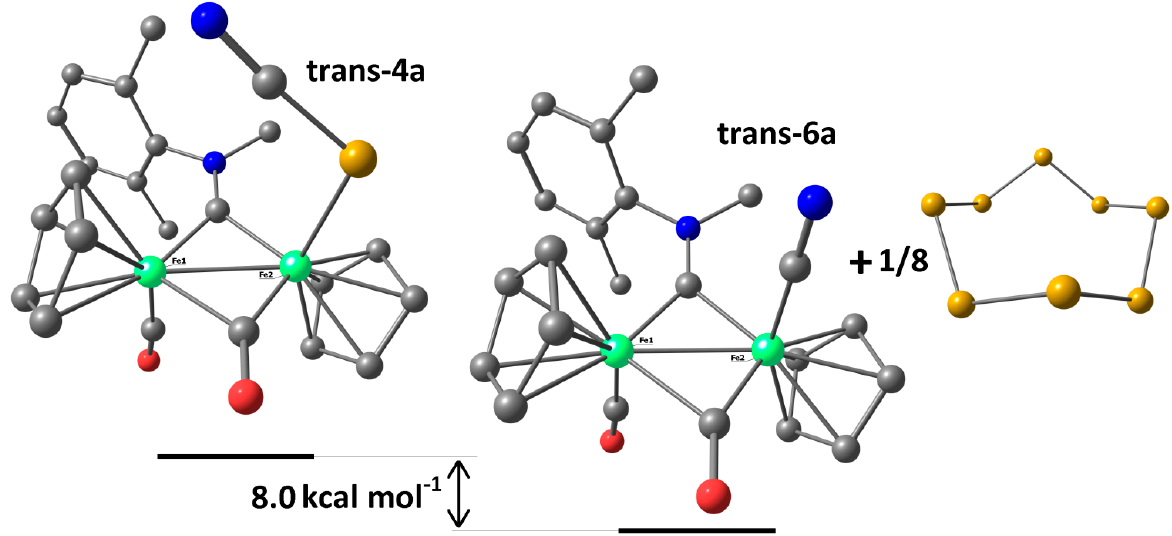
Figure 2. DFT-optimized structures of trans − 4a , trans − 6a , and Se 8 (C-PCM/PBEh–3c, acetone as continuous medium). Color map: Fe, green; Se, dark yellow; O, red; N, blue; C, grey; hydrogen atoms omitted for clarity. Selected computed bond lengths (Å): trans − 6a , Fe1–C(CO) 1.760, Fe1–C( µ CO) 2.089, Fe1 C(carbyne) 1.839, Fe1 C(Cp, average) 2.119, Fe2 C(CN) 1.893, Fe2 C(µ ‐ CO) 1.802, Fe2 C(carbyne) 1.858, Fe2 C(Cp, average) 2.123, Fe1 Fe2 2.523, C N(CN) 1.162,